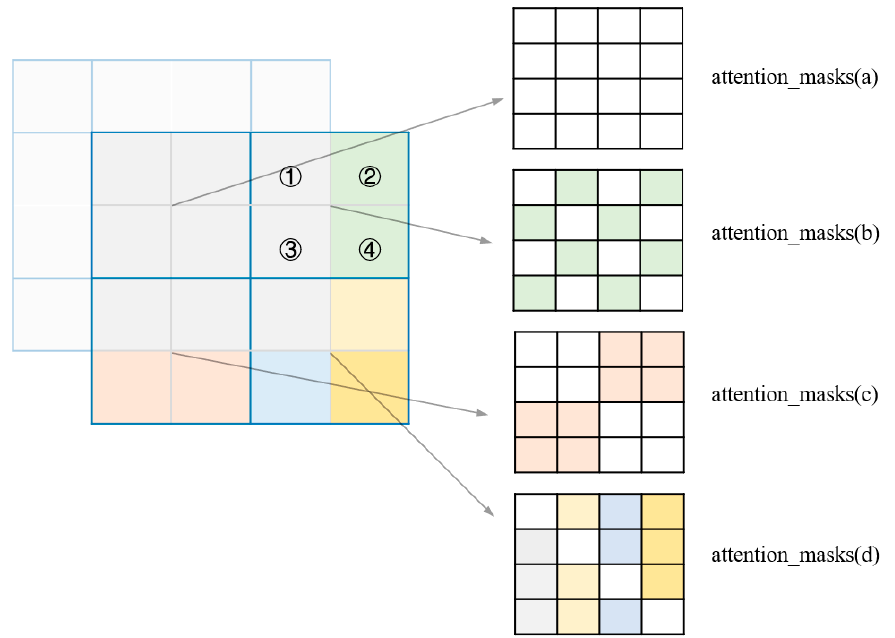
Figure 8. The working principle of masks. ① , ② , ③ , ④ represent a window combination respectively.